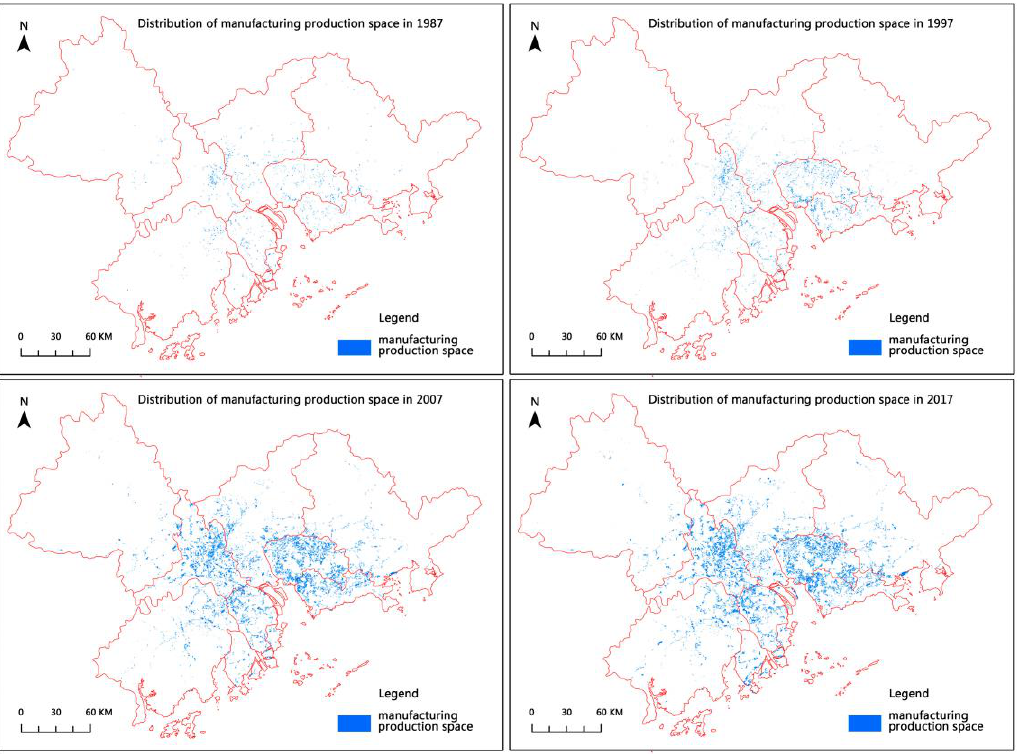
Figure 5. Spatial distribution of manufacturing production spaces in PRD in 1987 – 2017.